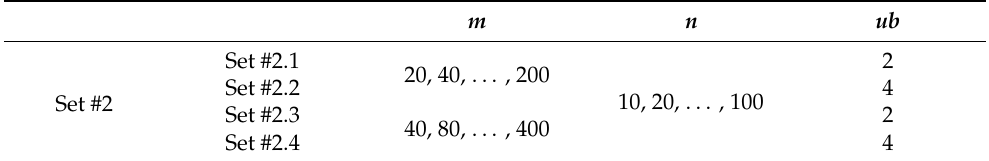
Table 6. The experimental setting of Set